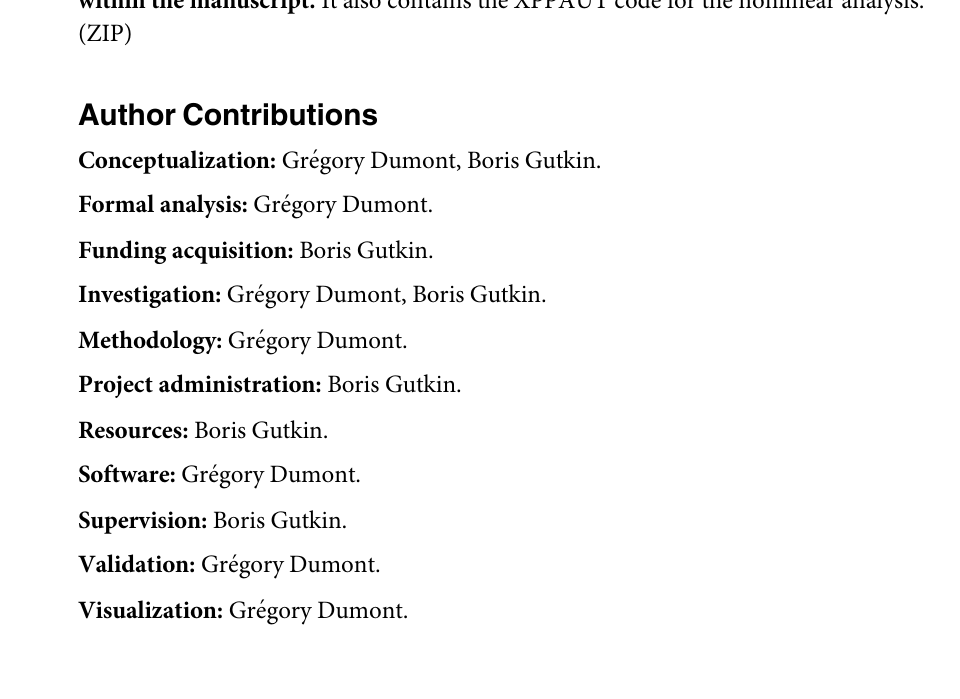
S9 Fig. PRC shapes. PRC shape as a function of parameters obtained via the adjoint method for different parameters for the PING. Parameters: τ = τ = 10; τ = τ = 1; � Z ¼ � Z ¼ (cid:0) 5 ; e i se si e i = 0; J = 15; J = 0; J = 15; I ext ¼ 0 , I ext ¼ 10 . J ee ei ii ie i e S10 Fig. PRC shapes. PRC shape as a function of parameters obtained via the adjoint method for different parameters for the ING. Parameters: τ = τ = 10; τ = τ = 1; � Z ¼ � Z ¼ (cid:0) 5 ; e i se si e i = 0; J = 10; J = 15; J = 0; I ext = 25. J ee ei ii ie S1 Code. The file contains the Matlab code used to make the different figures presented within the manuscript. It also contains the XPPAUT code for the nonlinear